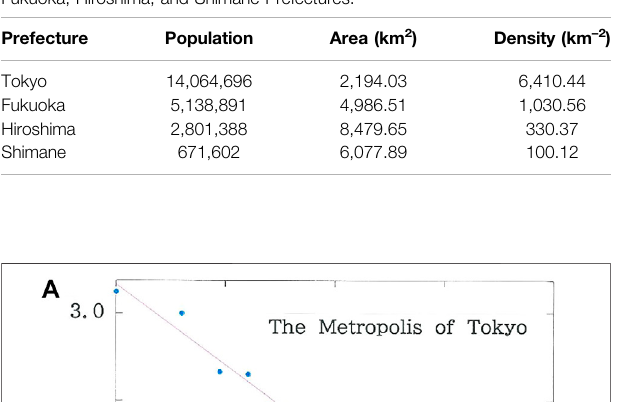
TABLE 3 | Comparison of optimal solutions ( q , | r |, d ) for the four prefectures in Table 2 .